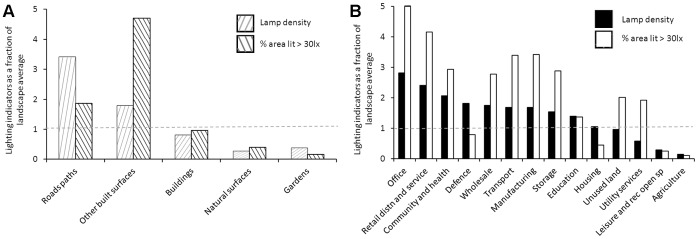
Lamp density and percentage illuminated area (≥30lx) for total city area covered by different land-uses.(A) OSMM land-use parcels and (B) NLUD land-use zones. Values have been standardised, with values >1 indicating abundance is greater than the landscape average.